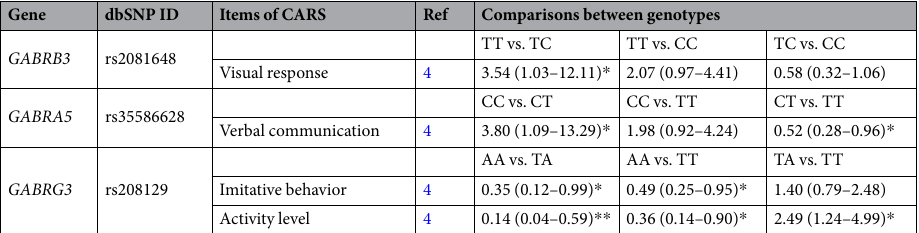
Table 3. Odds ratios (ORs) with 95% confidence intervals (CI) of having severe abnormality in items of CARS among genotypes of GABRB3 SNP rs2081648, GABRA5 SNP rs35586628, and GABRG3 SNP rs208129 in ASD patients. Ratings in items of CARS with a four-point scale (1 = appropriate for age; 2 = mildly abnormal; 3 = moderately abnormal; 4 = severely abnormal). The reference (Ref) rating is 4 in an ordinal polytomous logistic regression analysis (while adjusting for sex, age, and IQ). ASD patients for GABRB3 rs2081648: n = 14 TT, n = 44 TC, and n = 41 CC. ASD patients for GABRA5 rs35586628: n = 18 CC, n = 42 CT, and n = 39 TT. ASD patients for GABRG3 rs208129: n = 26 TT, n = 43 TA, and n = 30 AA. * p < 0.05; ** p < 0.01. ASD, autistic spectrum disorders; CARS, Childhood Autism Rating Scale; Ref, reference; vs., versus.